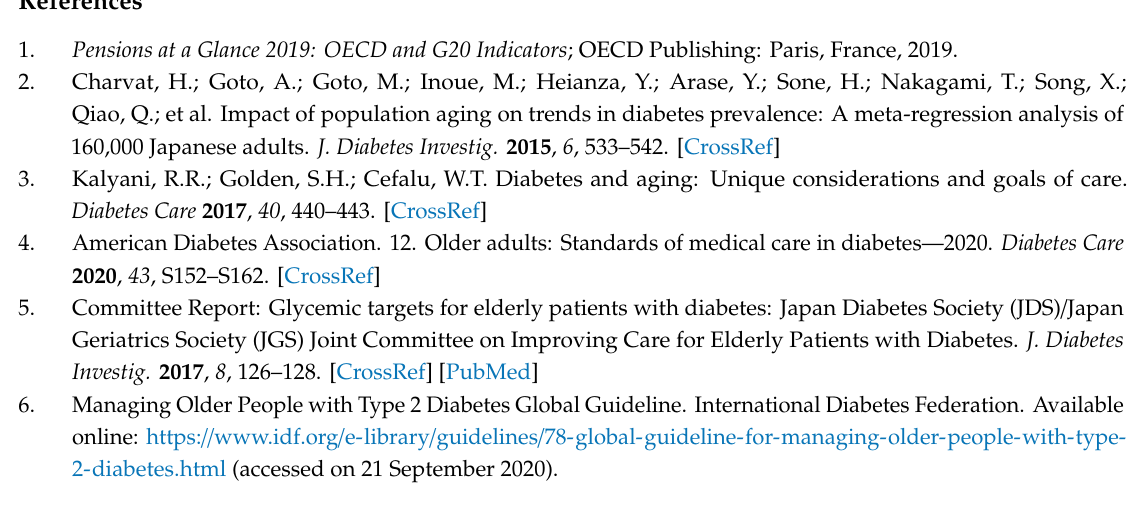
Table S1: Evidences of associations of nutritional status and mortality, frailty, sarcopenia and cognitive impairment, Table S2: Evidences of associations of energy, macro / micro-nutrient intake, dietary pattern and mortality, frailty, sarcopenia and cognitive